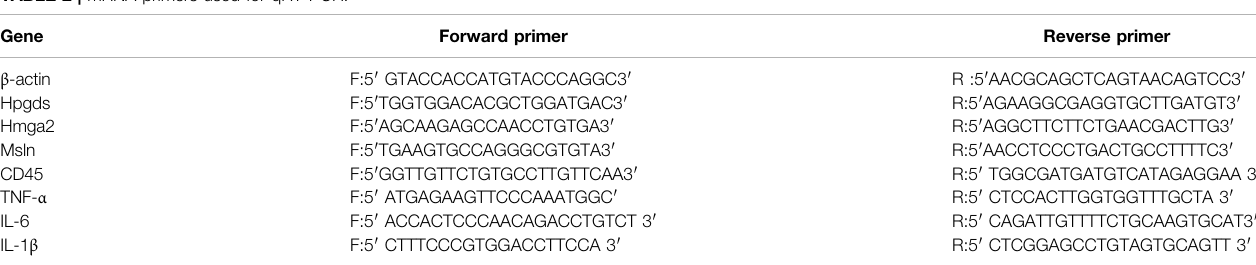
TABLE 2 | mRNA primers used for